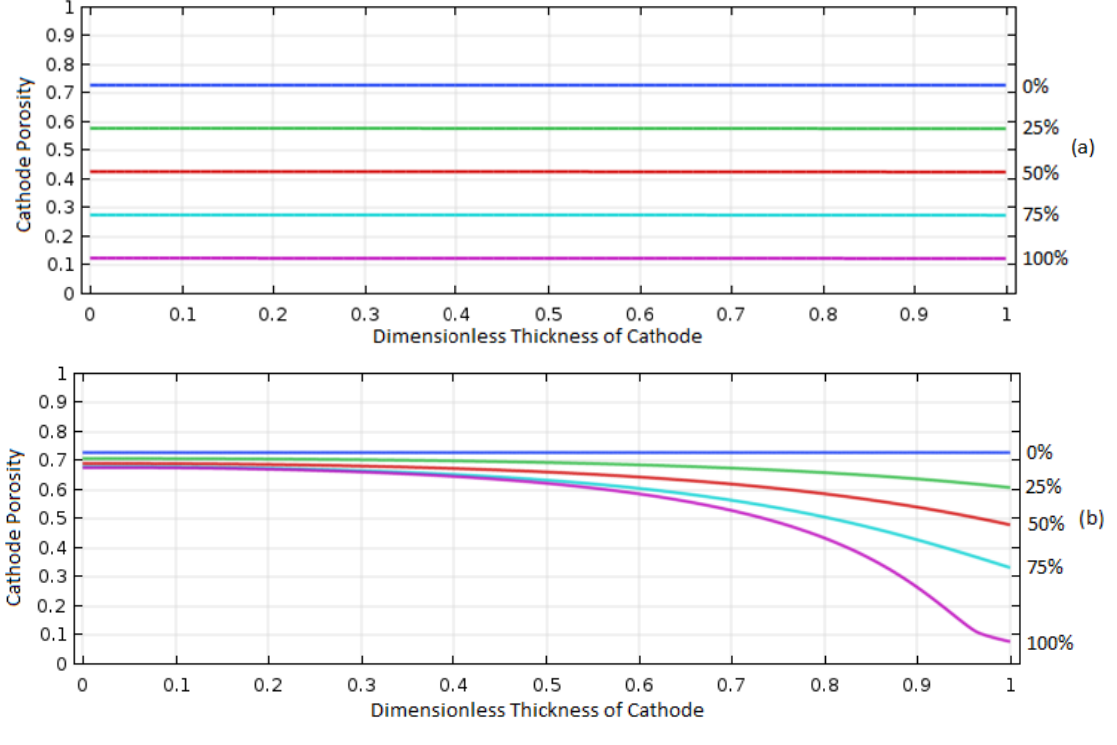
Figure 12. Distribution of cathode porosity from 0% to 100% discharge at 1 A/m 2 current density for a) 25 μ m and b) 1600 μ m cathode thickness, with 0.49 O 2 solubility and 0.73 cathode porosity.